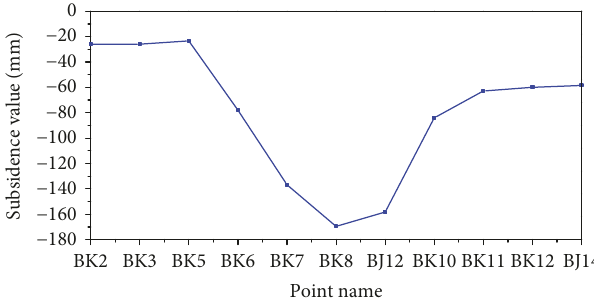
Figure 13: Final curve of surface subsidence in the III644 working face.